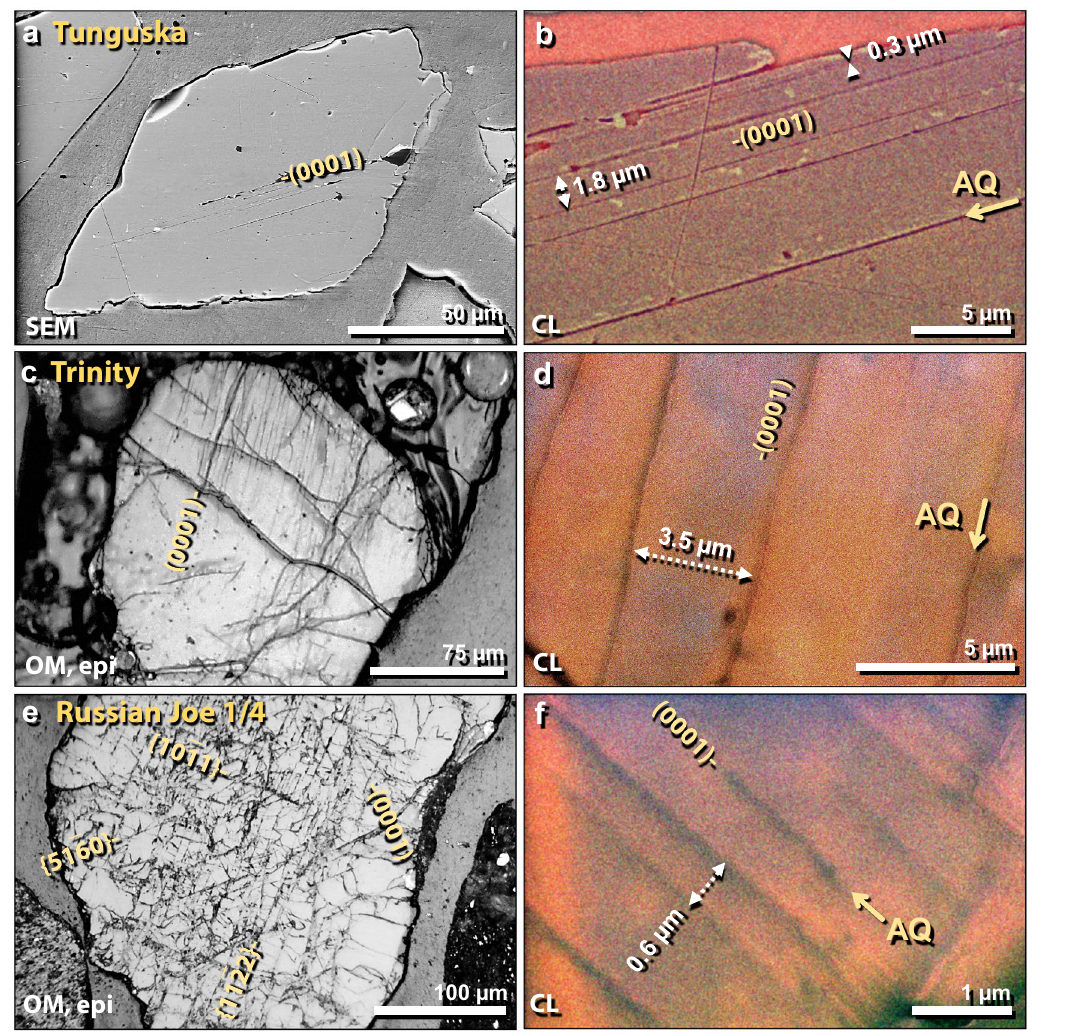
Figure 21. Shocked quartz from known airbursts. ( a ) SEM image of 140-µm-wide shocked quartz grain from Tunguska airburst. Discontinuous lamellae formed along the (0001) plane. ( b ) Close-up SEM-CL image of same grain as in panel ‘ a ’. Lamellae spacing ranges from ~ 0.3 to 5 µm. Black lamellae indicate amorphous quartz (AQ). ( c ) Epi-illumination photomicrograph of 240-µm-wide shocked quartz grain embedded in trinitite that was ejected ~ 400 m from ground zero of the Trinity detonation. Discontinuous, sub-planar, sub-parallel lamellae are oriented along the (0001) plane. ( d ) Close up SEM-CL image of same grain as in panel ‘ c ’. Lamellae spacing ranges from ~ 2.5 to 6.5 µm. Black lamellae indicate amorphous quartz (AQ). ( e ) Epi-illumination photomicrograph of 520-µm-wide shocked quartz grain from Russia’s Joe-1/4 nuclear detonations; displays discontinuous sub-planar, sub-parallel micro-fractures and lamellae, just as reported for impact-shocked grains in the Charlevoix crater 56 . There are four sets of lamellae, one of which is oriented parallel to the (0001) plane. ( f ) Close up SEM-CL image of same grain as in panel ‘ e ’. Lamellae spacing ranges from ~ 0.3 to 1.3 µm. Black lamellae indicate amorphous quartz